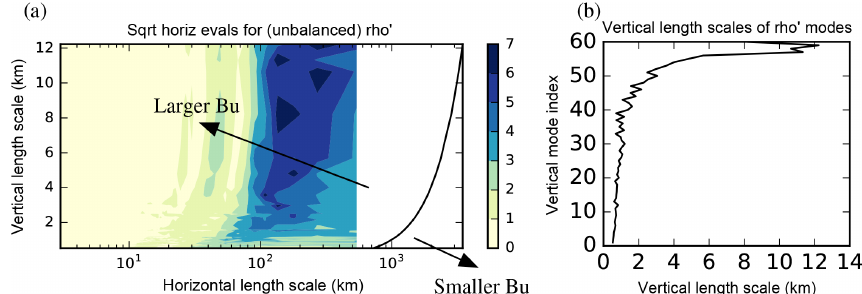
Figure 6. (a) The same horizontal spectra of Fig. 5c but shown as a function of horizontal ( l h ) and vertical ( l v ) length scales. Also shown in (a) is the Rossby radius of deformation, L R , plotted as a function of l v (black line). The Burger number is defined as Bu = L R /l h . (b) Vertical length scales ( x axis) of the vertical modes ( y axis) for the unbalanced scaled density control parameter, calculated according to Appendix C.